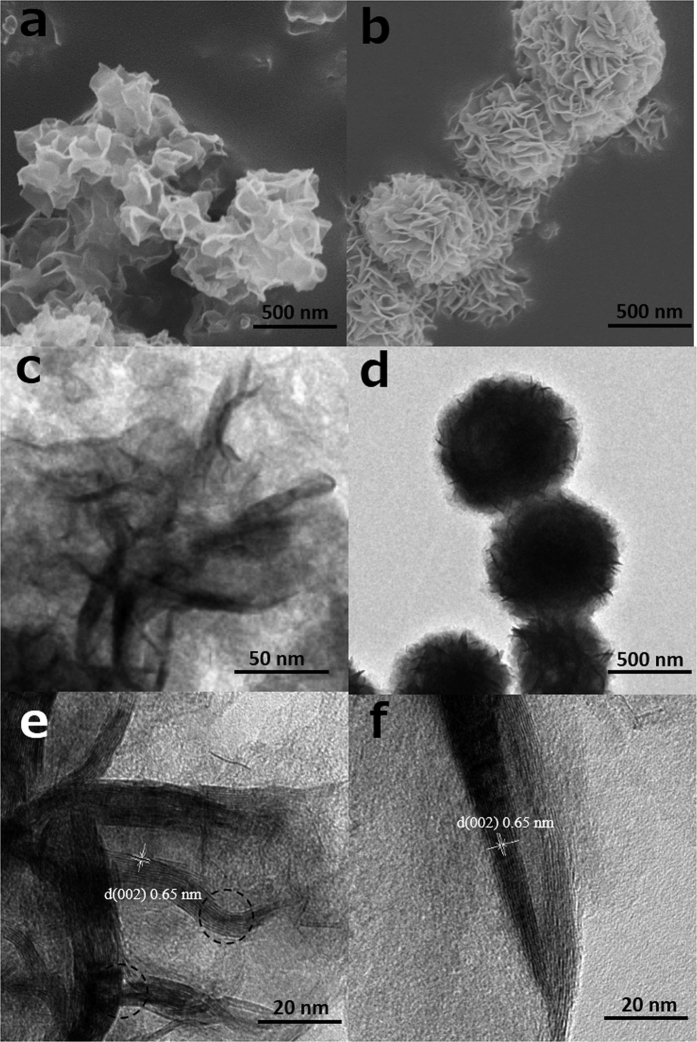
(a) SEM image of MoS2-P; (b) SEM image of MoS2; (c) TEM image of MoS2-P; (d) TEM image of MoS2; (e) HRTEM image of MoS2-P; (f) HRTEM image of MoS2.